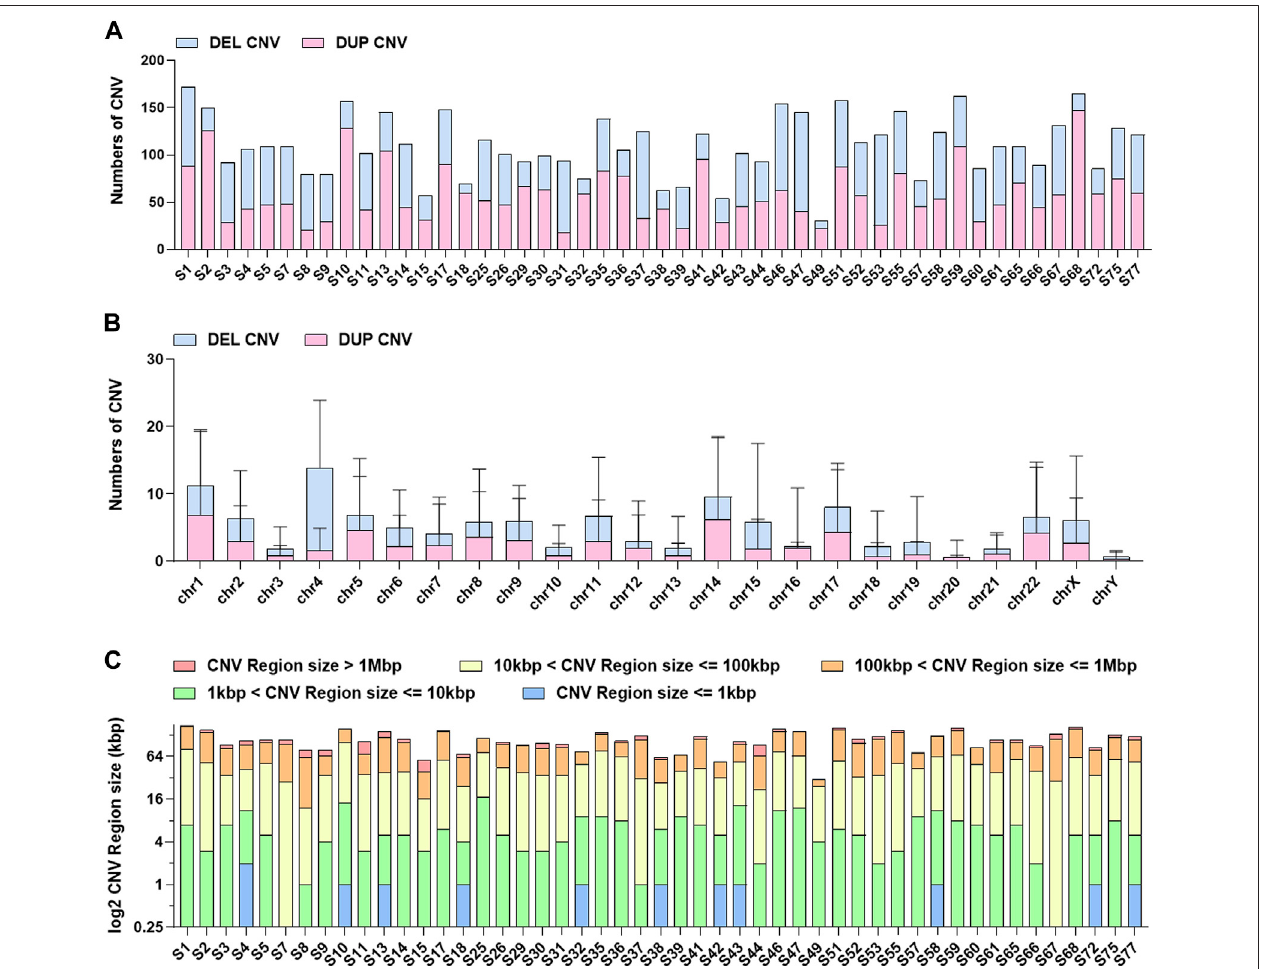
FIGURE5| ThedistributioninformationofCNVsin49GISTs. (A) Thenumberdistribution ofCNVsineachGIST. (B) ThedistributionofCNVsineachchromosome. (C) The length distribution of CNVs in each GIST.